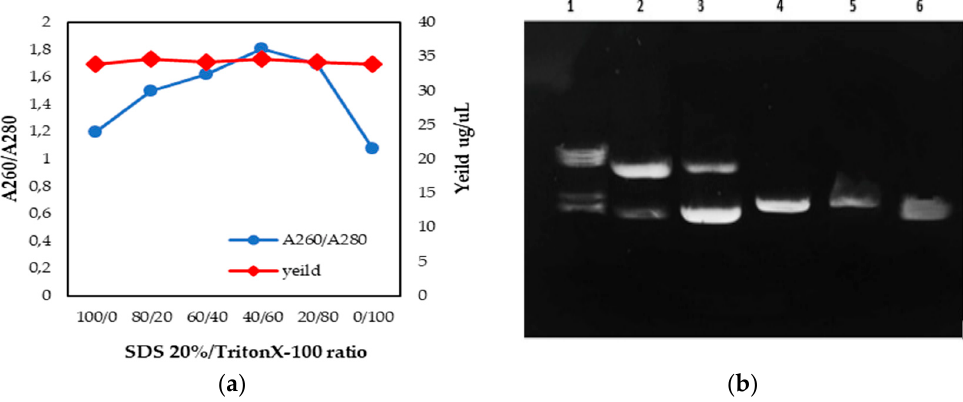
Figure 4. DNA was extracted and purified from Tetrahymena pyriformis (GL, L 1630/1) using the SDS 20%/TritonX-100 method. ( a ) Overview of DNA quality and quantity (NanoDrop), according to the SDS/Triton X-100 ratio—a description of what is contained in the second panel. ( b ) Electrophoretic analysis of Tetrahymena pyriformis DNA, isolated using various SDS/Triton X-100 ratios. Each lane indicates a different sample (lane 1: 100/0; Lane 2: 80/20; Lane 3: 60/40; Lane 4: 40/60; Lane 5: 20/80; Lane 6: 0/100).